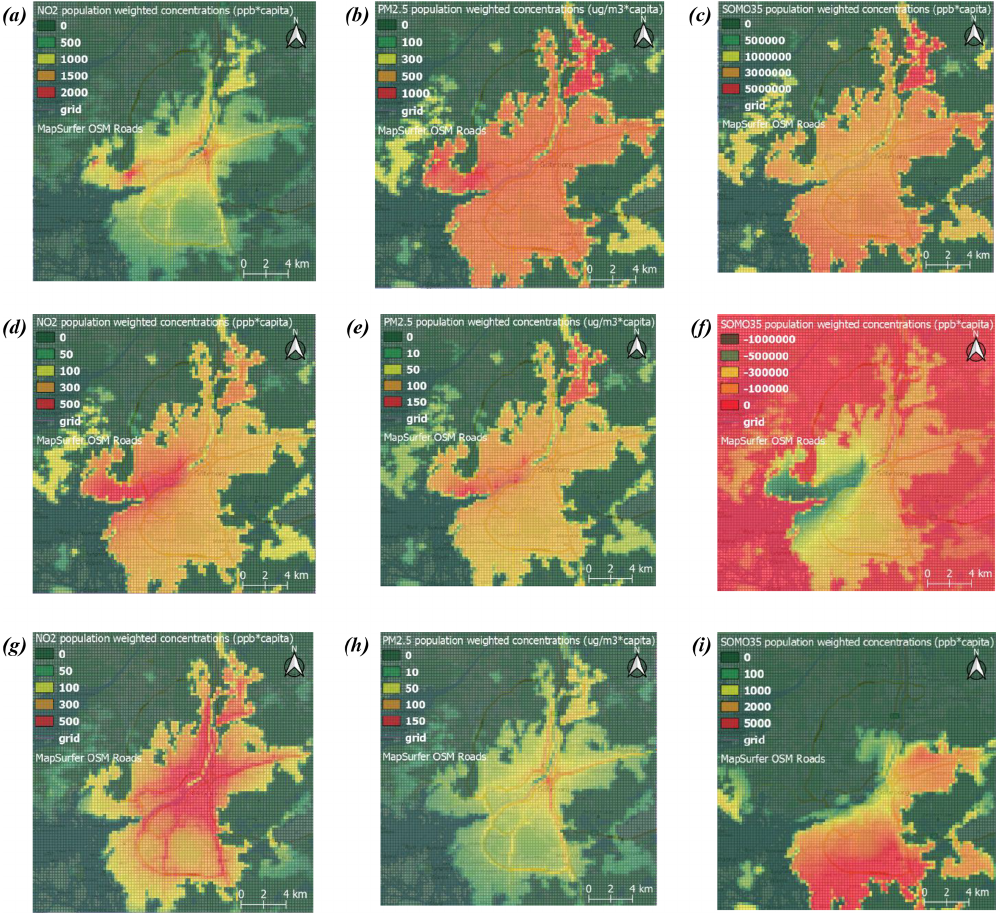
Figure 12. The population-weighted annual mean concentrations for NO 2 (ppb × capita), PM 2 . 5 (µgm − 3 × capita) and SOMO35 (ppb × h × capita): (a) NO 2 in the base simulation, (b) PM 2 . 5 in the base simulation, (c) SOMO35 in the base simulation, (d) NO 2 from local and regional shipping, (e) PM 2 . 5 from local and regional shipping, (f) SOMO35 from local and regional shipping, (g) NO 2 from road traffic, (h) PM 2 . 5 from road traffic and (i) SOMO35 from road traffic. Base map credits: © OpenStreetMap contributors 2020. Distributed